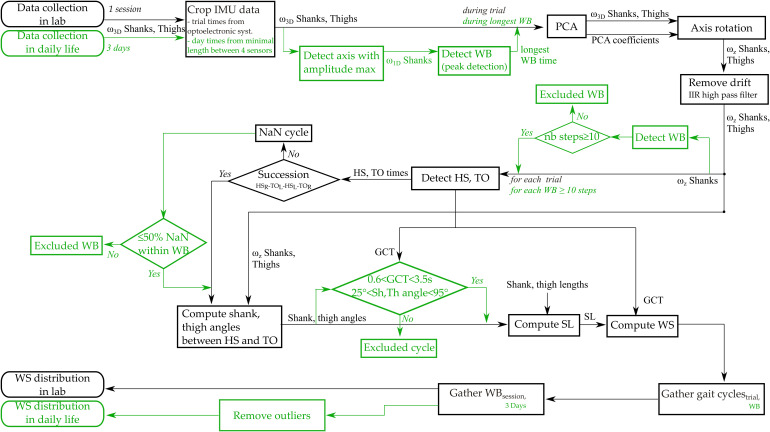
Flow chart of data processing steps. In green are represented the steps specific to daily life measures. Abbreviations: ω1D: 1-axis angular velocity; ω3D: 3-axis angular velocity; ωz: pitch angular velocity; PCA: Principal Component Analysis; WB: Walking bout; IIR: infinite impulse response; nb steps: number of steps; HS: Heel strike; TO: Toe off; HSR: Heel strike right; HSL: Heel strike left; TOR: Toe off right; TOL: Toe off left; NaN: Not A Number; GCT: Gait Cycle Time; Sh,Th: Shank and thigh; SL: Stride length; WS: Walking speed.